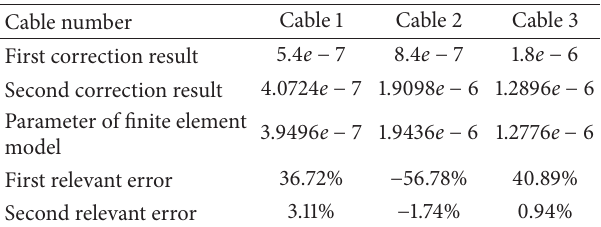
Table 7: Second updating result for moment of inertia (m 4